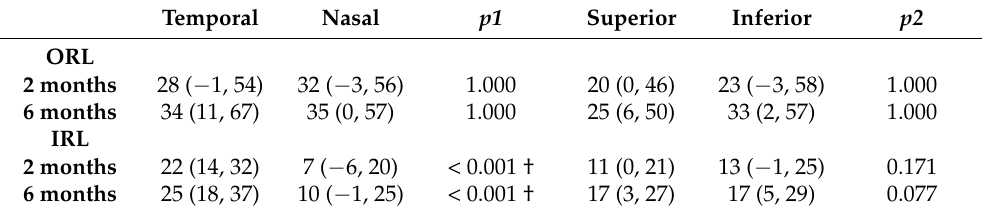
Table 2. Reduction of inner and outer retinal thickness in each quadrant in the patients with DONFL during the different postoperative periods.